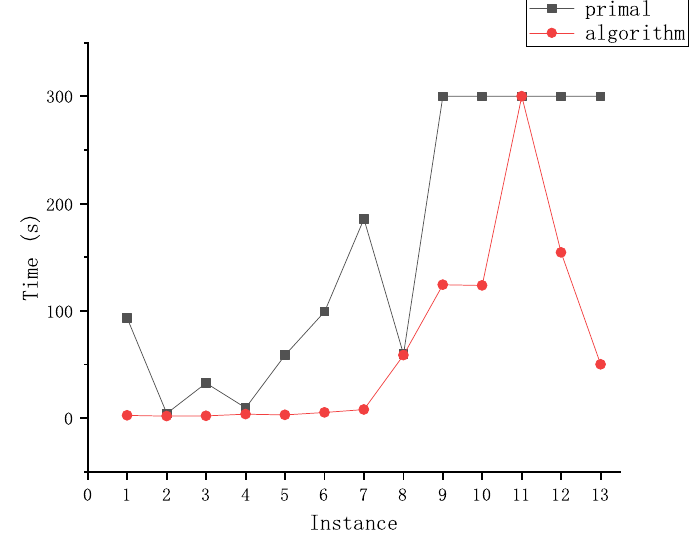
Figure 5. Running time for middle-scale instances.